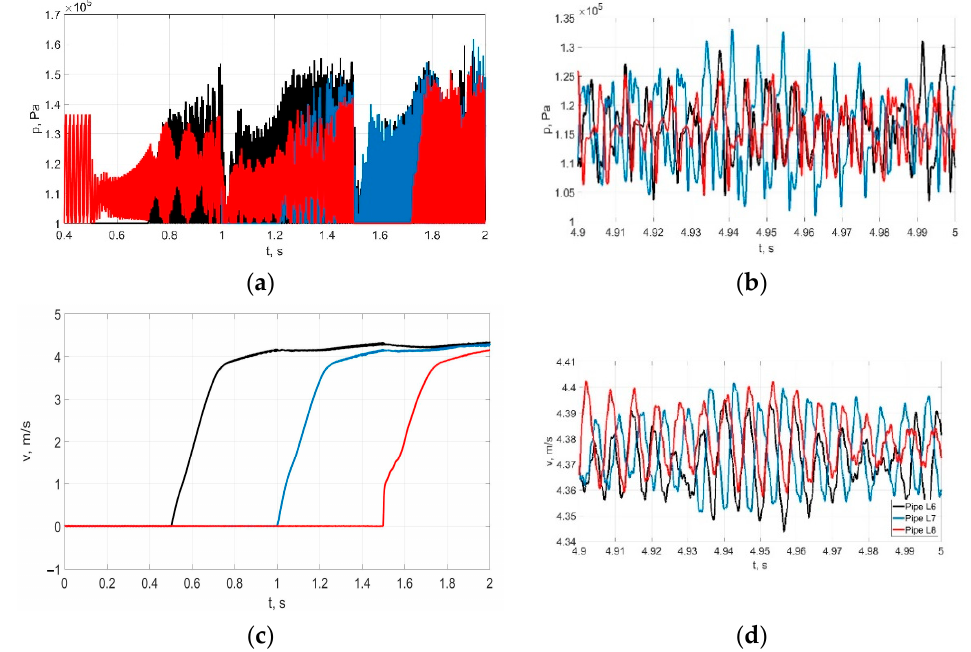
Figure 14. Pressure in the 6th, 7th, and 8th pipes (Table 2) of the LNG transportation system: Note: ( a ) Pressure observation when the system starts working; ( b ) Pressure observation at the end of the solution time; ( c ) Velocity observation when the system starts working; ( d ) Velocity observation at the end of the solution time.